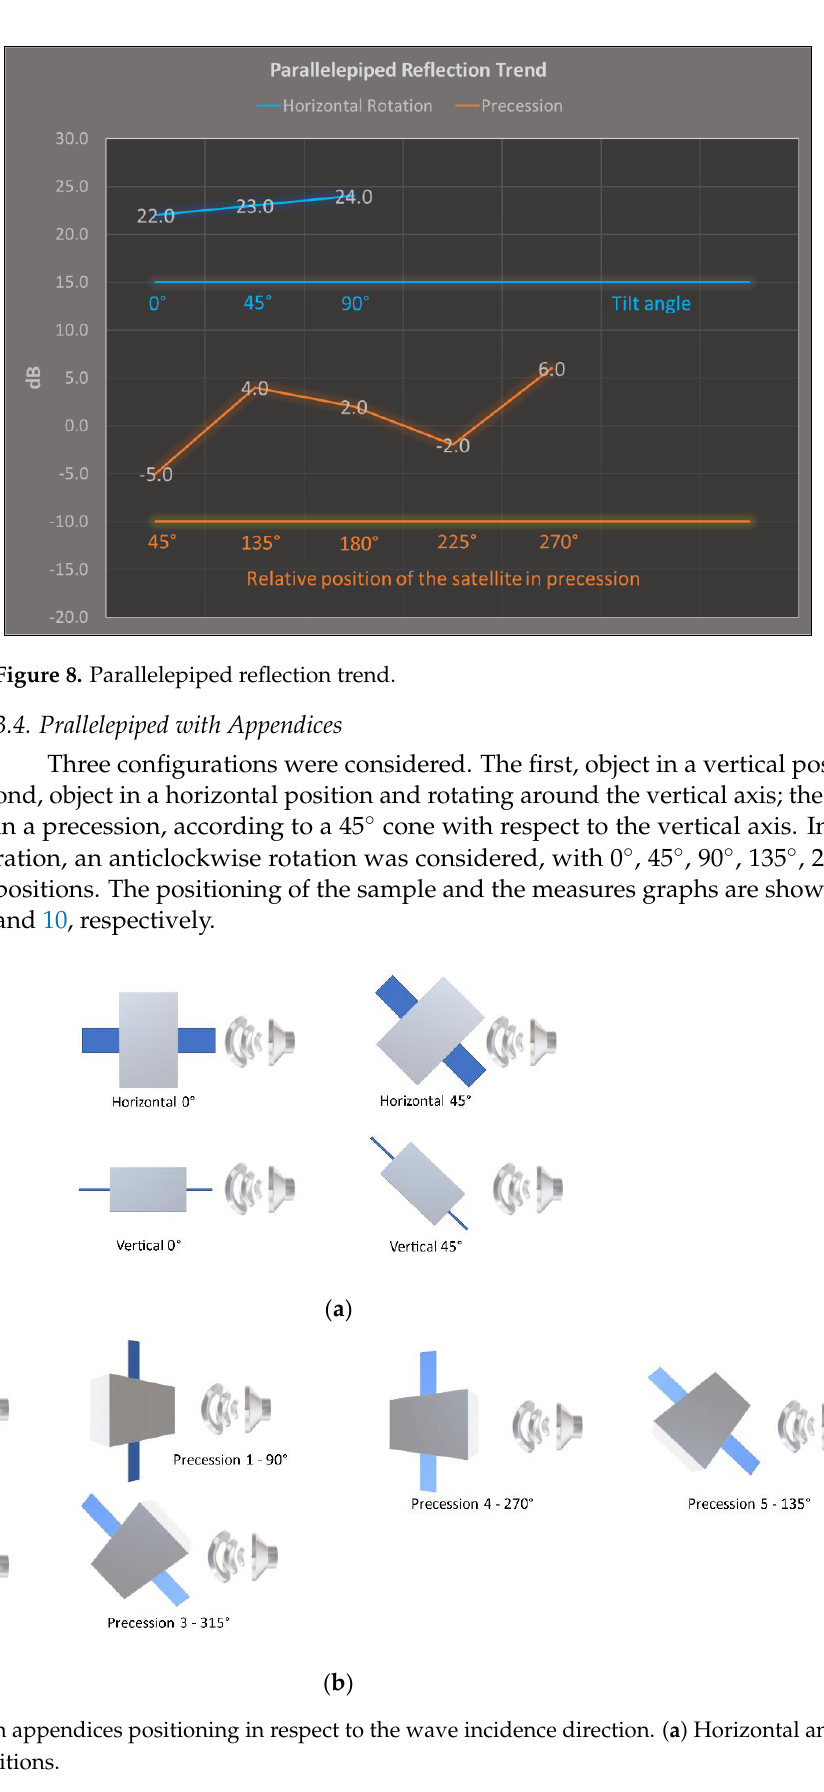
Figure 10. Parallelepiped with appendices signal reflection: TE polarization reflection vs. frequency. The case with the highest reflection is the horizontal position, with an increasing trend between 13 and 23 dB of reflection at the extreme frequencies. Vertical, vertical at 45° of rotation on the longitudinal axis, and horizontal at 45° of rotation on the longitudi- nal axis measures have a more flattened trend starting from 13 dB at 12 GHz and ending at 10 dB at 18 GHz. It is also important to note that several spikes on the plots are visible for all the positions at the same frequencies (16.5 GHz, 16.7 GHz, 17 GHz, 17.4 GHz, 17.8 GHz). All the precession positions are visible at 18 GHz, except position Precession 3. From 15.5 GHz to 18 GHz, satellites in Precession 0 and Precession 2 are always visible, while objects in the Precession 1 position are visible between 17.3 and 18 GHz only. At lower frequencies, from 12 to 13.8 GHz, satellites in the Precession 2 position are not visible, while Precession 0 and 1 present the highest values of reflection. The test campaign leads to the consideration that scaled objects, in horizontal, verti- cal, vertical at 45° of rotation on the longitudinal axis, and horizontal at 45° of rotation on